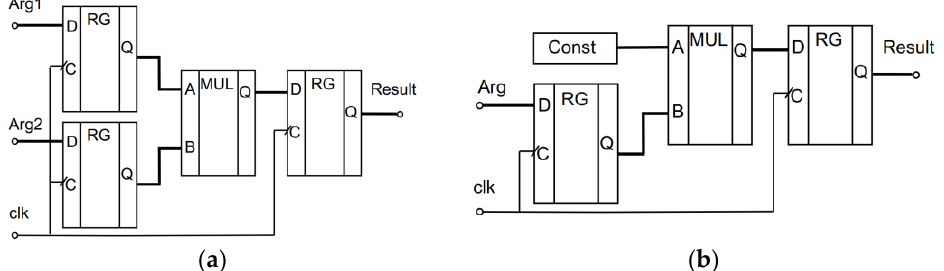
Figure 5. Multiplier test setup: ( a ) multiplier of two signals, ( b ) multiplier of signal by constant.